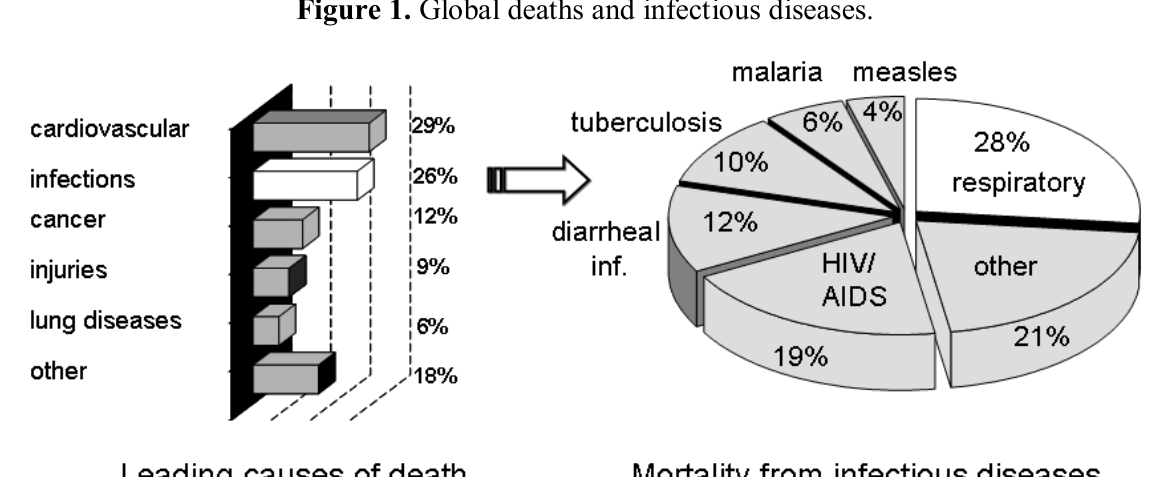
Figure 1. Global deaths and infectious